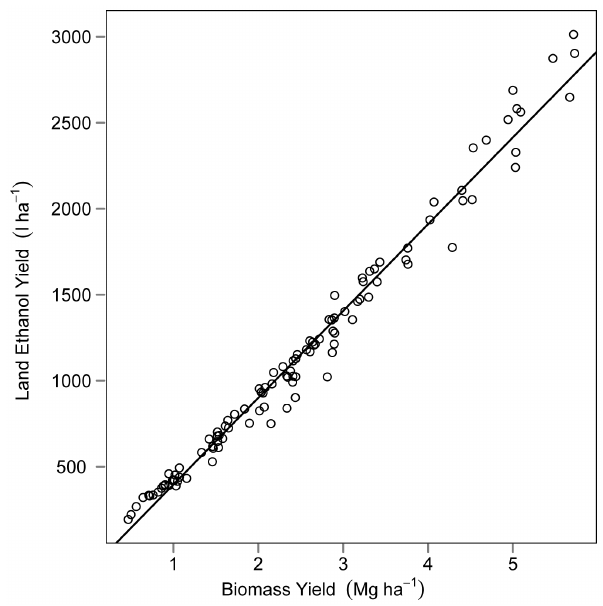
Figure 4. Correlation between land ethanol yield (l ha 2 1 ) and biomass yield (Mg ha 2 1 ). Points represent values from conservation grasslands harvested in the autumn of 2009, 2010, and 2011. Regression line from linear model with R-squared value=0.98.